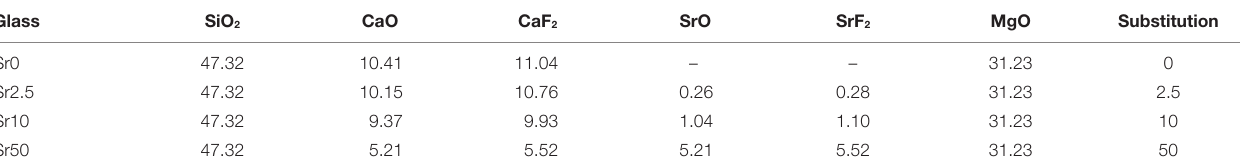
TaBle 1 | nominal glass composition (mol%) and strontium for calcium substitution (%).